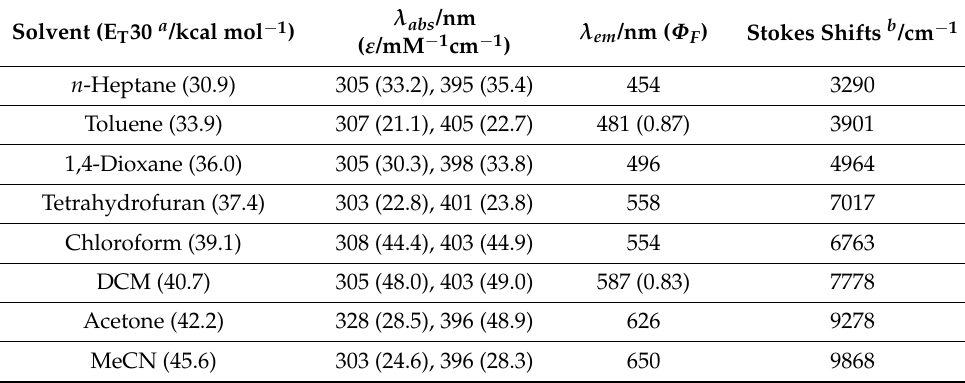
Table 1. Photophysical properties of compound 1 in a series of aprotic solvents.